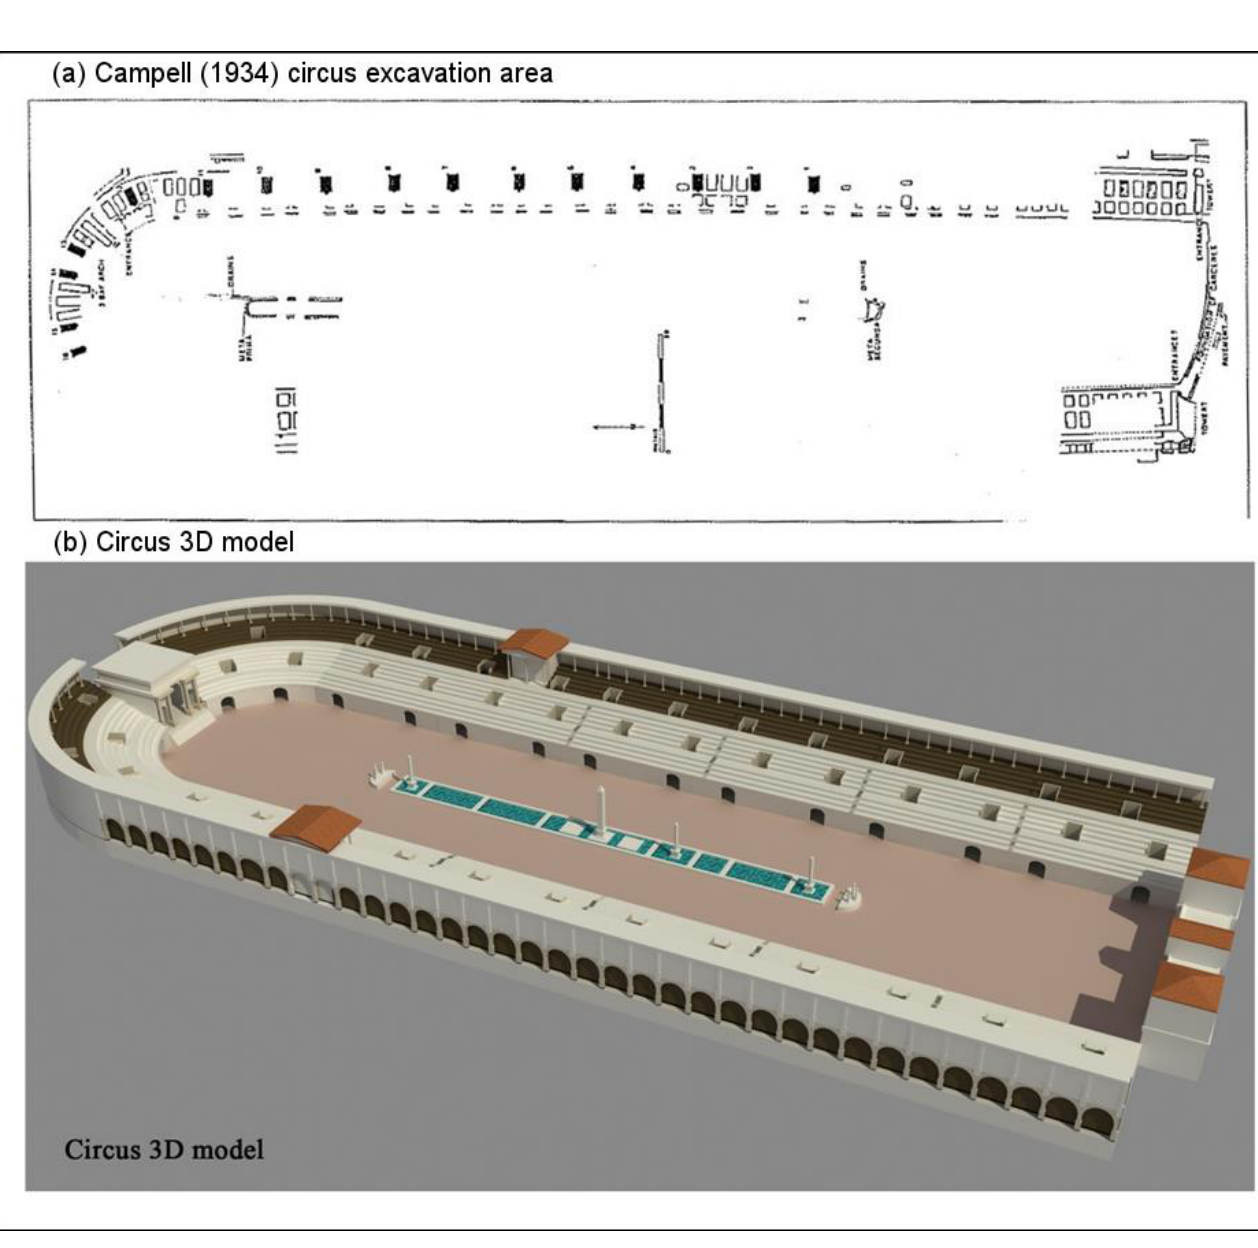
Figure 8. Campell’s (1934) [21] circus excavation area and model produced from his